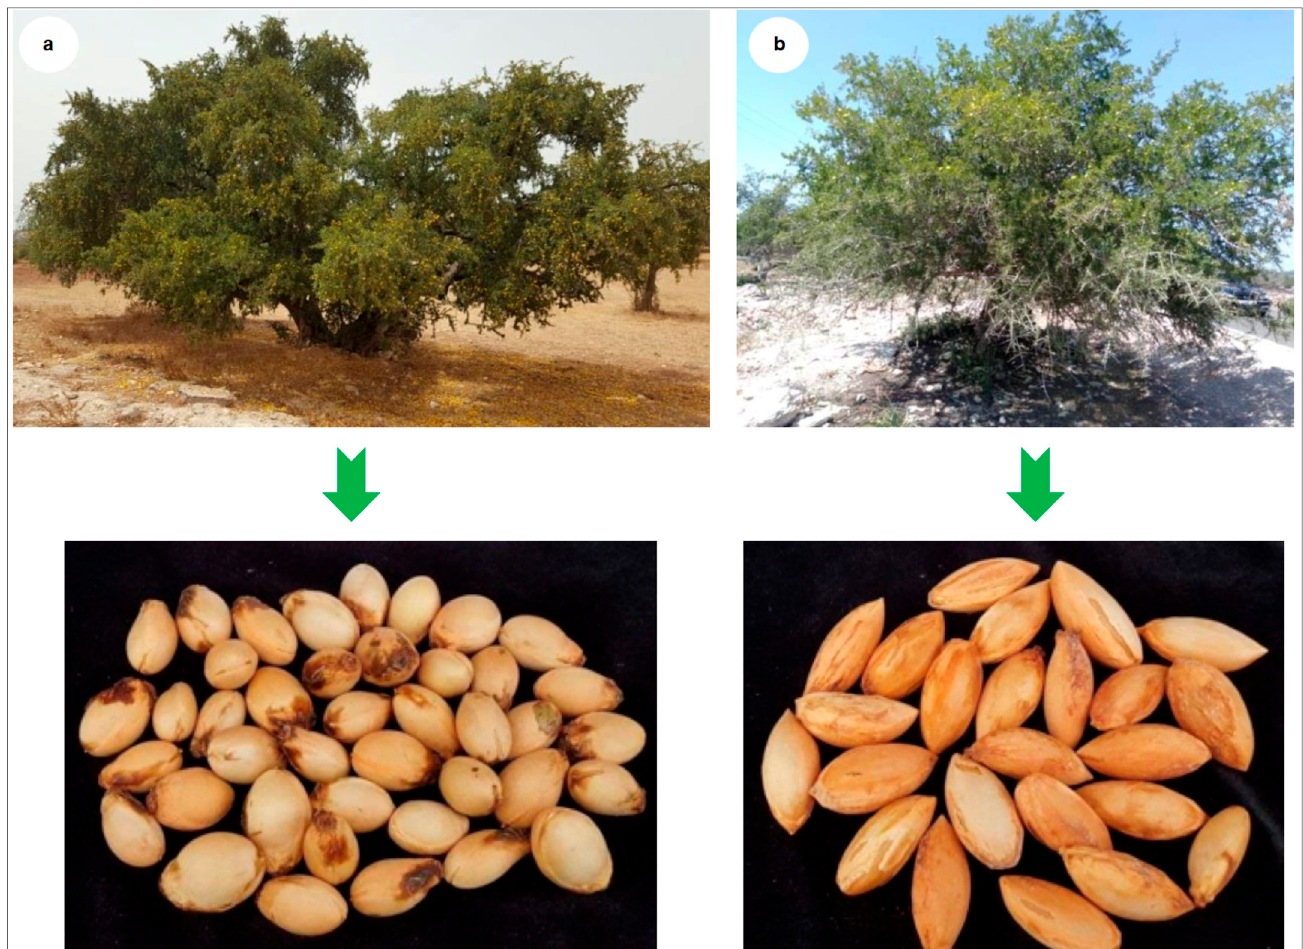
Figure 4. Argan trees and seeds. ( a ) genotype “Mejji” and ( b ) genotype “R’zwa”. The seeds were surface-sterilized by immersion in 70% ethanol for 2 min, followed by immersion in 30% sodium hypochlorite solution containing a few drops of Tween-20 for 15 min. The seeds were then immersed in 0.1% mercury chloride for 10 min, followed by 3 rinses with sterile distilled water, then by immersion in 0.2% polyvinylpyrrolidone solution for 60 min [24]. To promote germination, the seeds were soaked in 10 mg L − 1 GA 3 for 12 h and then cultured for 35 days on sucrose-free 1/2MS medium modified by omitting ammonium nitrate [24].